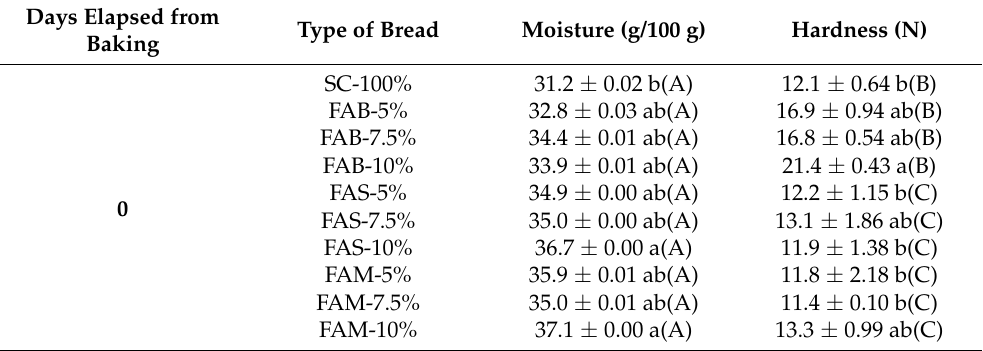
Table 7. Variation of moisture content and hardness of durum wheat bread at increasing levels of replacement (5, 7.5, 10%) of re-milled semolina (control) with flours prepared from artichoke stems and bracts during 5 days of